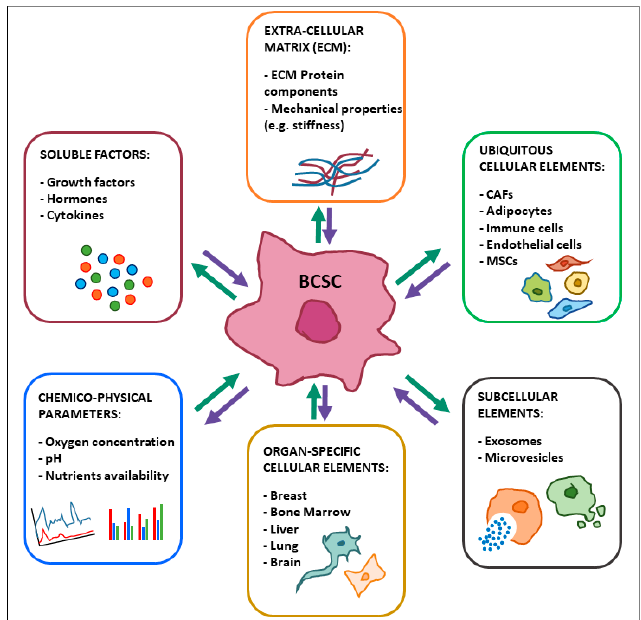
Figure 2. Crosstalk between breast cancer stem cells (BCSCs) and microenvironmental factors. CAFs: Cancer-Associated Fibroblasts; MSCs: Mesenchymal Stromal Cells.